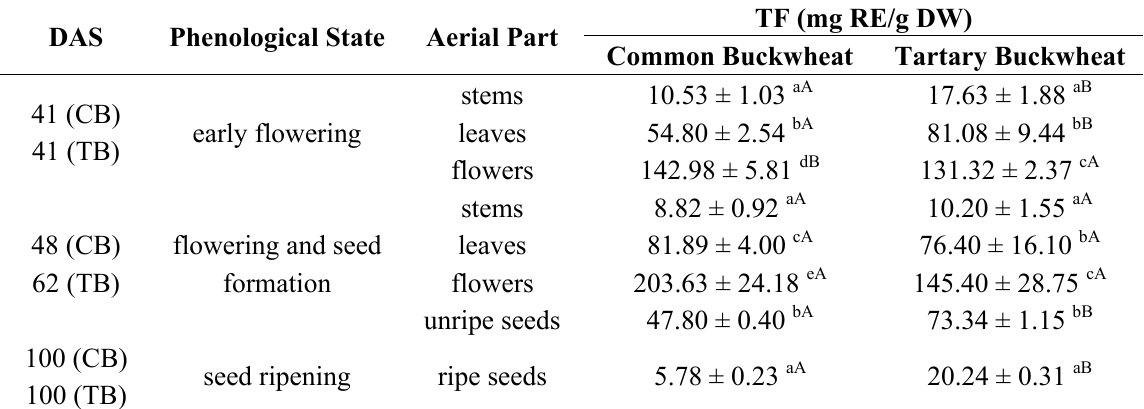
Table 1. Phenological state and total flavonoids (TF) content in the aerial parts of common (CB) and tartary (TB)